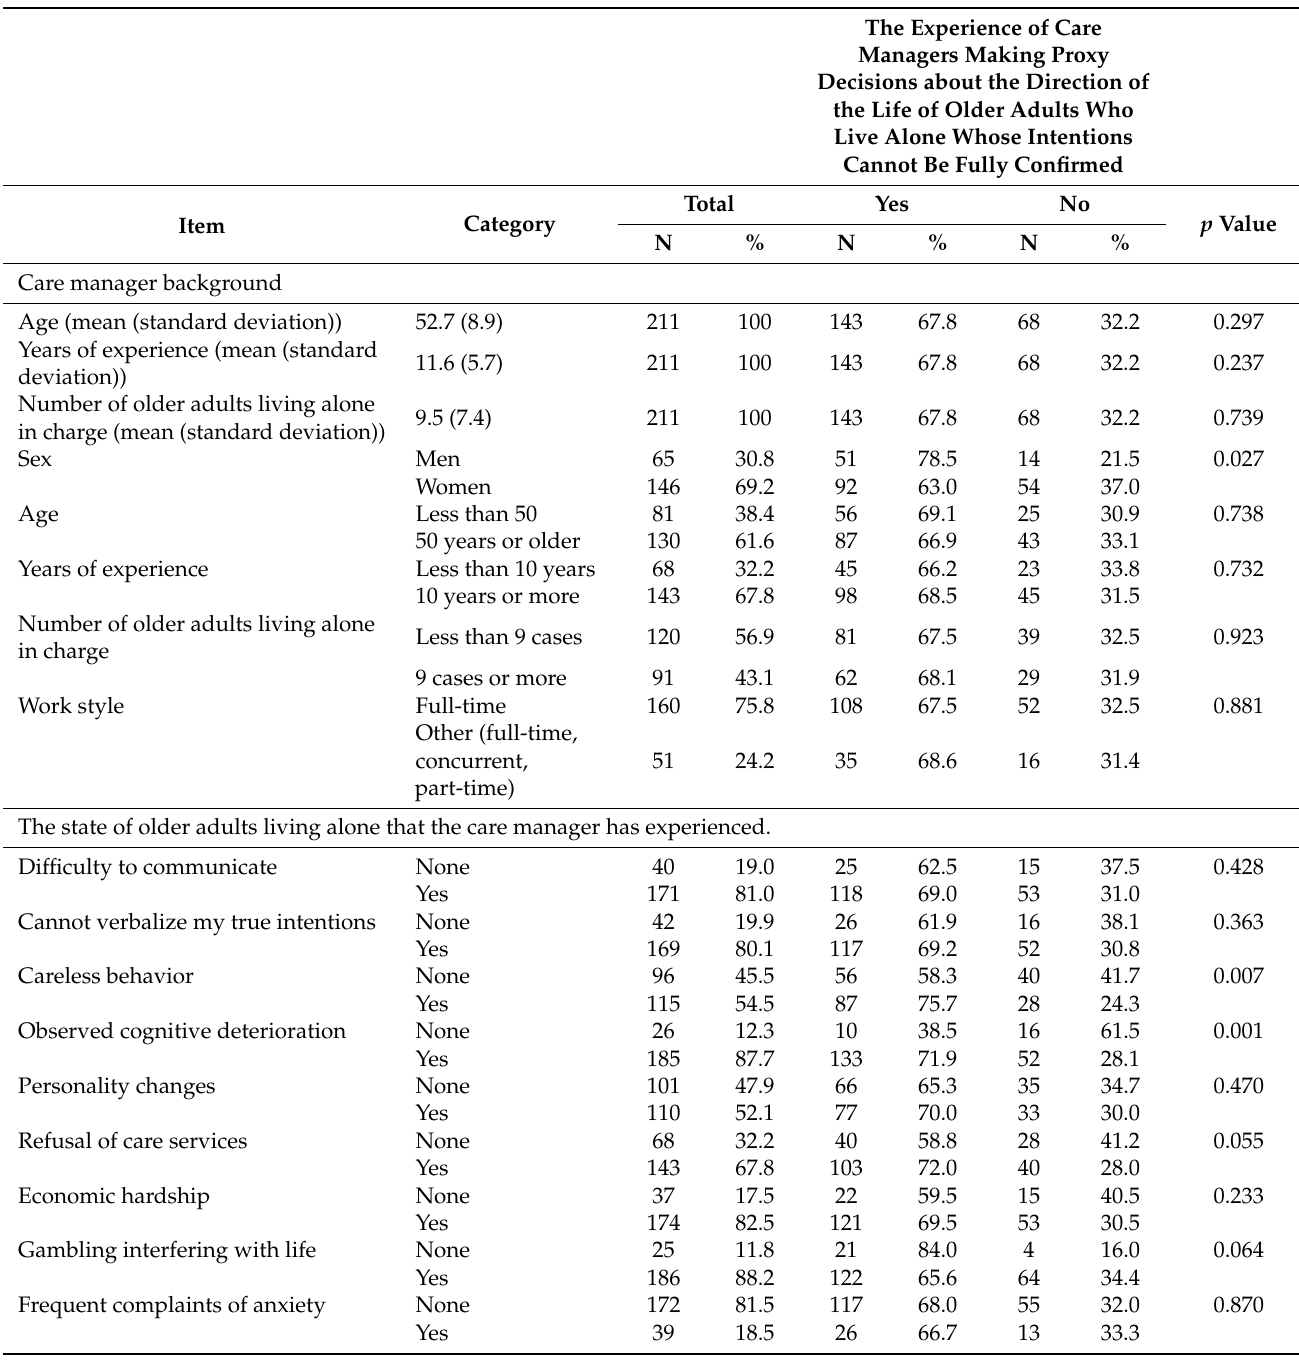
Table 1. Care managers’ experiences of making decisions on behalf of older adults living alone ( n = 211).